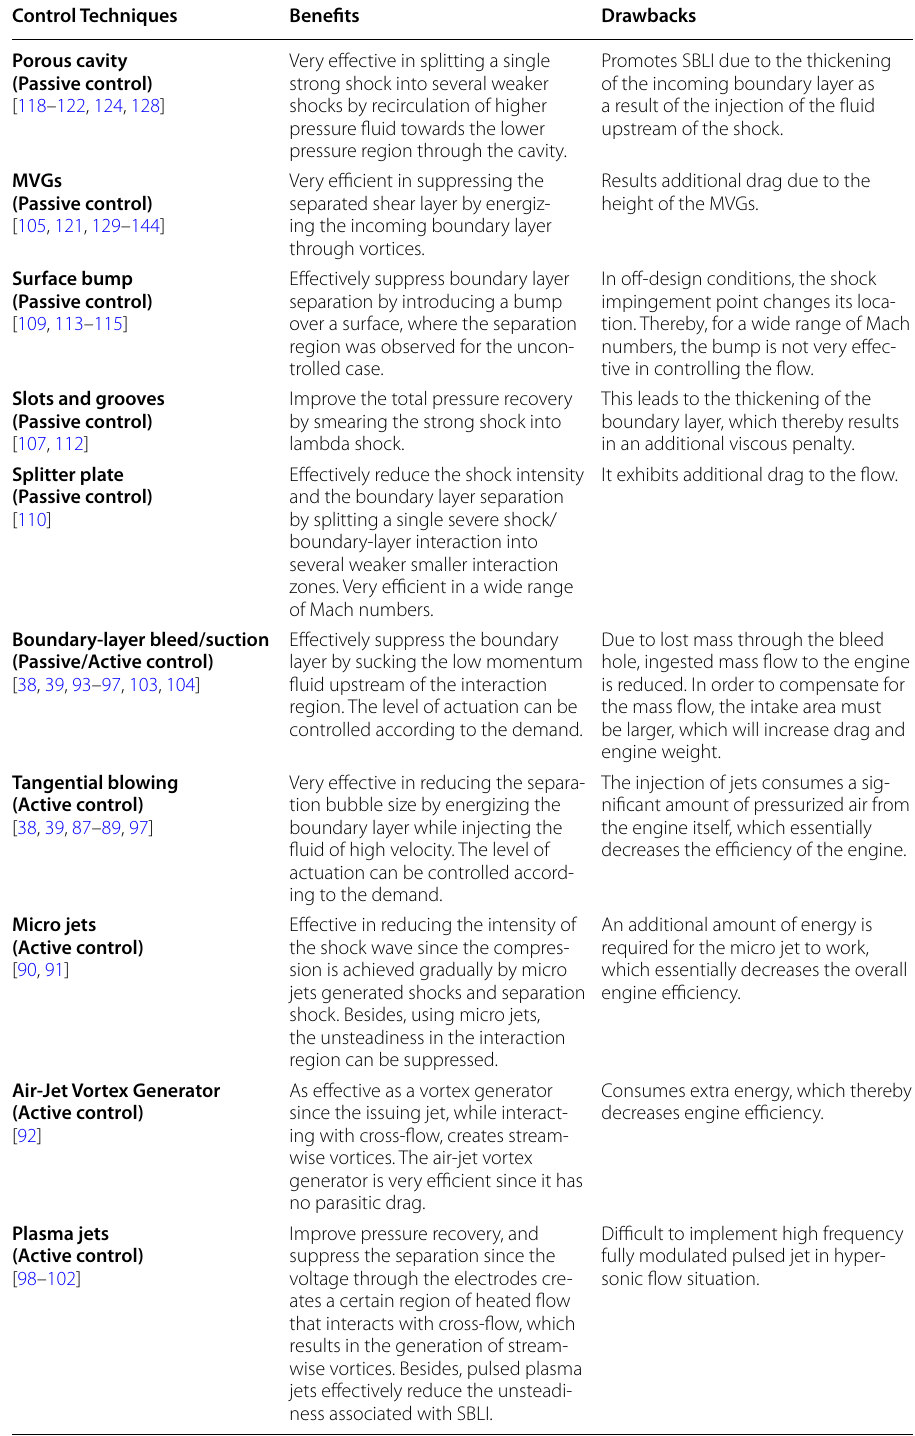
Table 1 Key technologies in controlling SBLI with their benefits and drawbacks Control